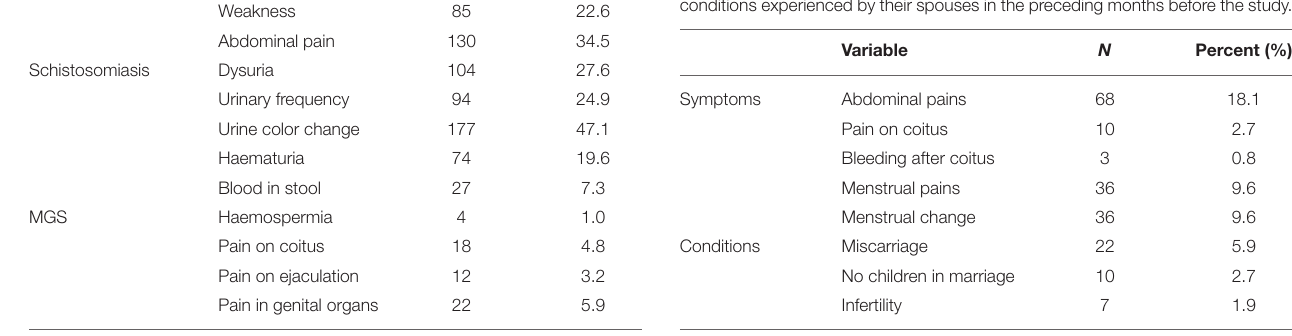
TABLE 5 | Proportion of all 376 participants who reported experiencing symptoms of schistosomiasis including MGS. Symptoms n Percent (%) General